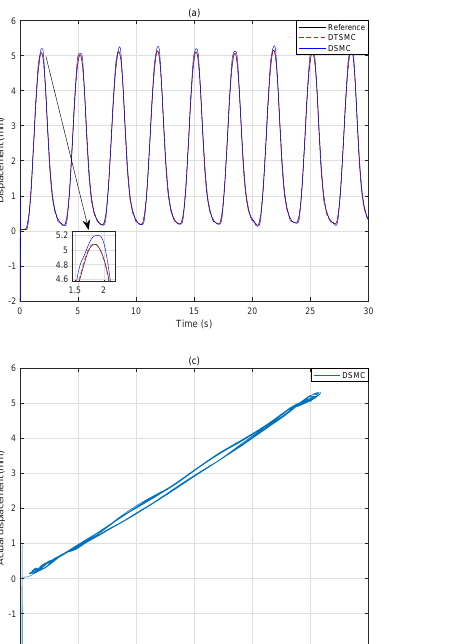
Figure 11. The tracking results under 0.2 Hz input signal. ( a ) Displacement output. ( b ) Tracking error. ( c ) Desired displacement versus actual displacement of the DSMC. ( d ) Desired displacement versus actual displacement of the DTSMC.